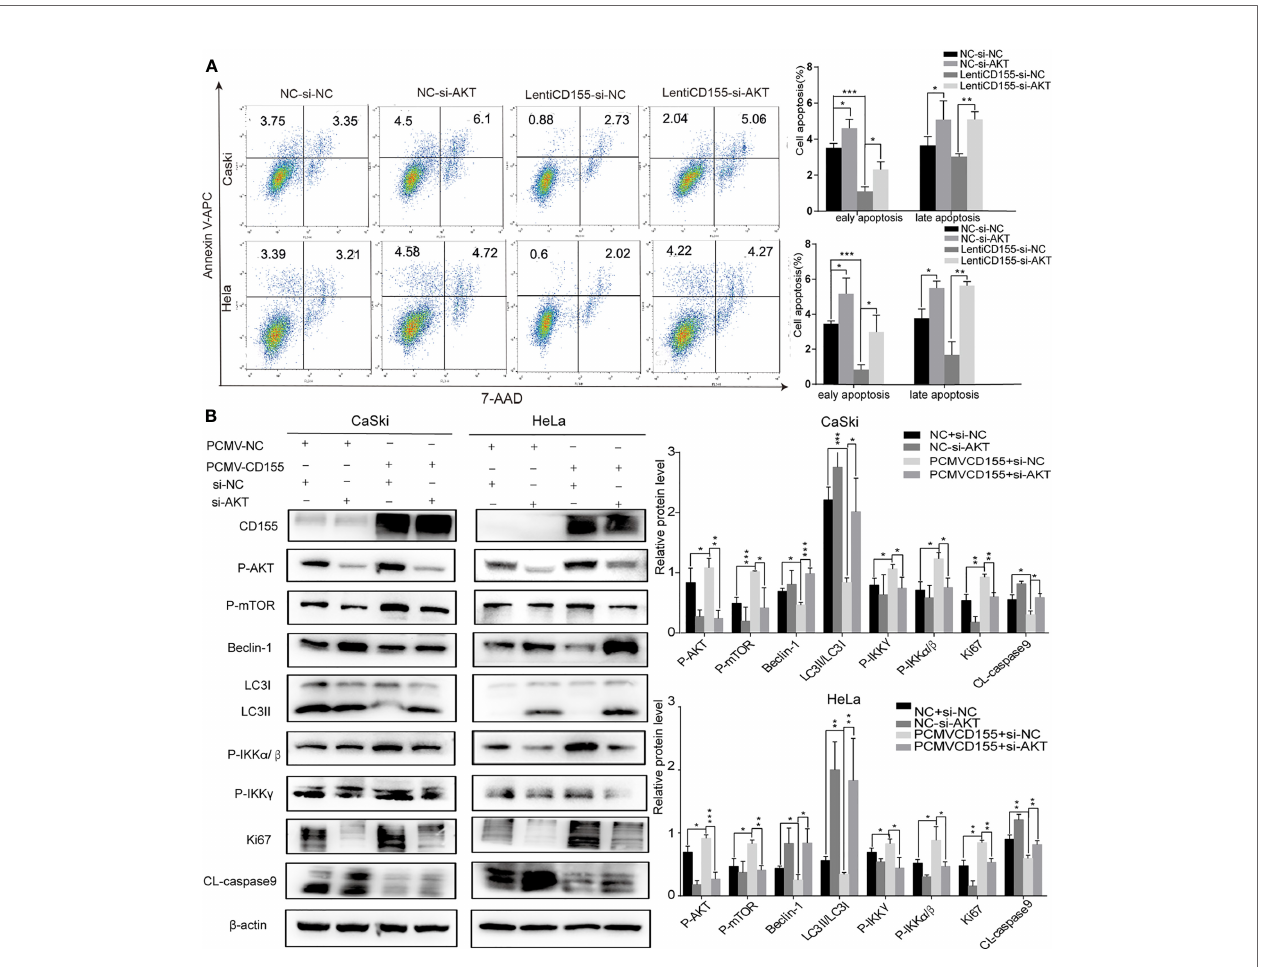
FIGURE 5 | AKT knockdown reverses the anti- apoptotic effects and activation of the AKT/mTOR/NF- k B pathway induced by CD155 overexpression. CaSki and HeLa cells overexpressing CD155 were transfected with AKT-siRNA (A) Flow cytometry was used to detect apoptosis after staining with APC Annexin-V and 7AAD. The apoptotic ratio in CaSki and HeLa cells was quantitatively analyzed with FlowJo v10. (B) The expression of CD155, p-AKT, p-mTOR, Beclin-1, LC3BI, LCBII, p- IKK g , p-IKK a / b , CL-caspase9, and Ki67 was measured by western blot. b -actin was used as a control. Quantitation was performed using Image J, and the data are the mean ± SEM of at least three independent experiments. *P < 0.05, **P < 0.01, and ***P <